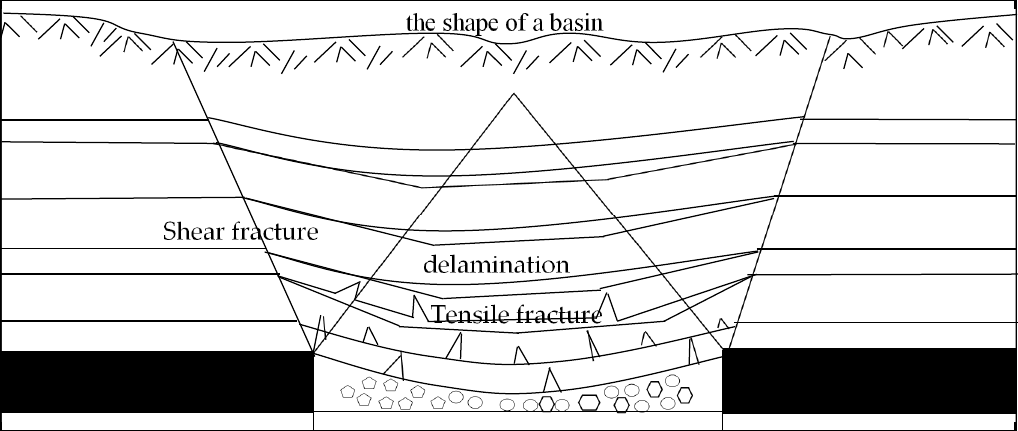
Figure 3. Evolution diagram of rock fractures.